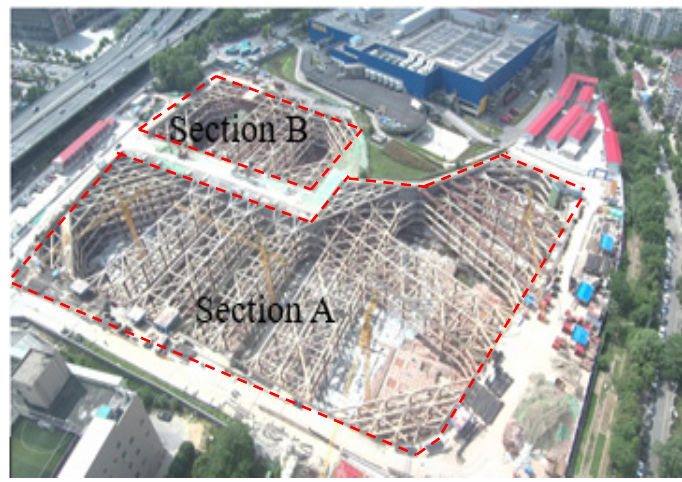
Figure 1. Layout plan of foundation pit section.